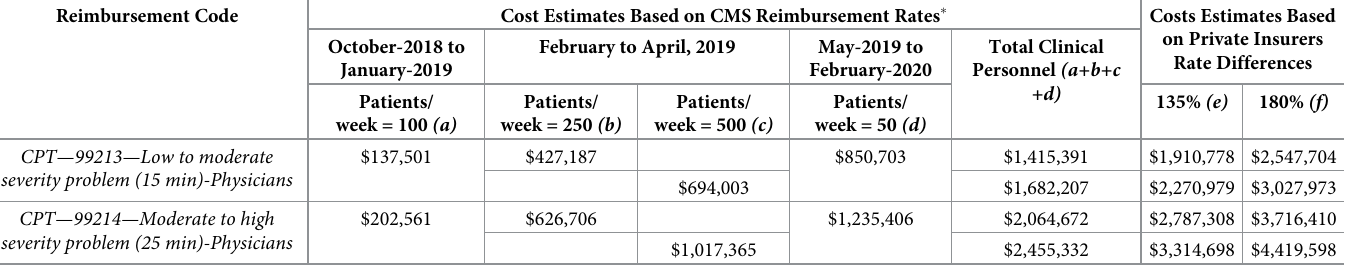
Table 4. Sensitivity analysis of estimated costs of treating asylum seekers and refugees entering El Paso, Texas October 2018 to February 2020 (costs estimates pre- sented in 2020 US dollars). Reimbursement